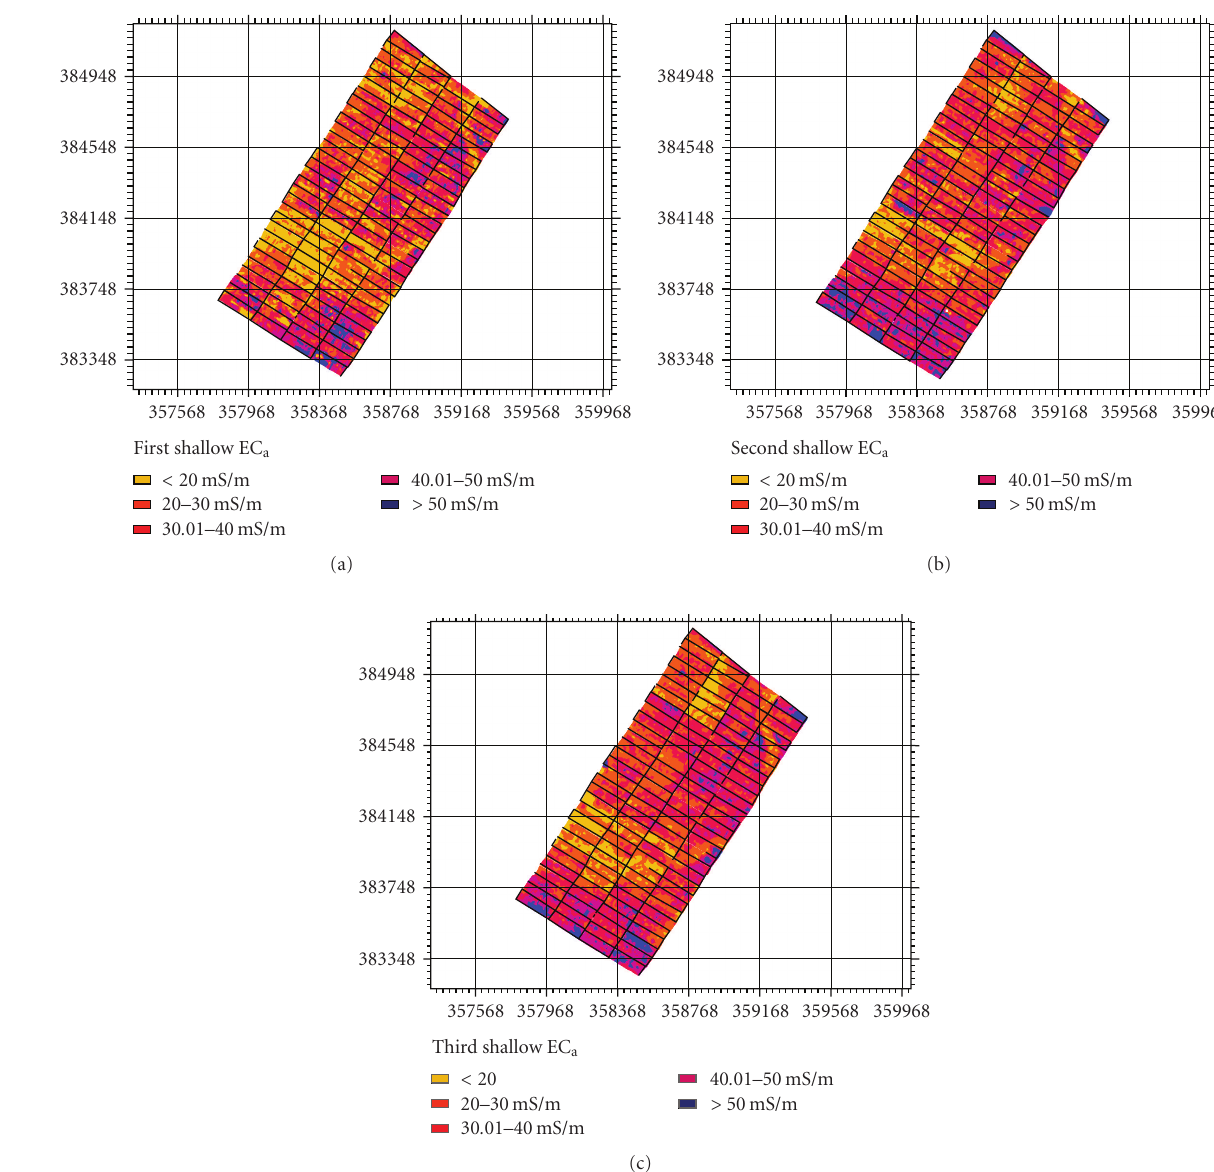
Figure 2: Kriged Map for shallow EC a (mSm − 1 ) classified by smart quantiles (a) Season 1, (b) Season 2, and (c) Season